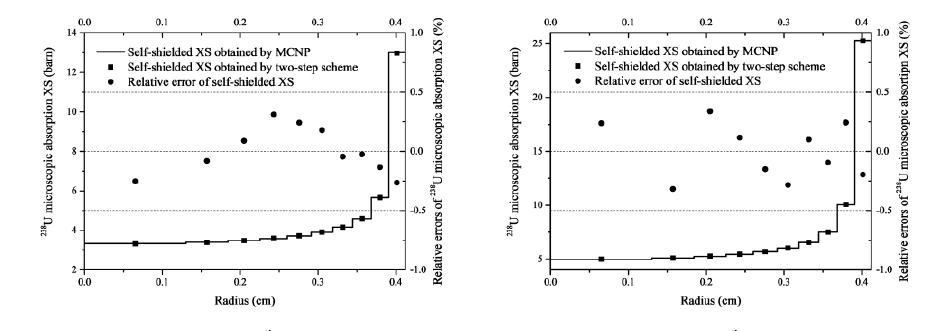
Figure. 5 The Comparison Of 238 U Microscopic Absorption XS in No.1 Rod